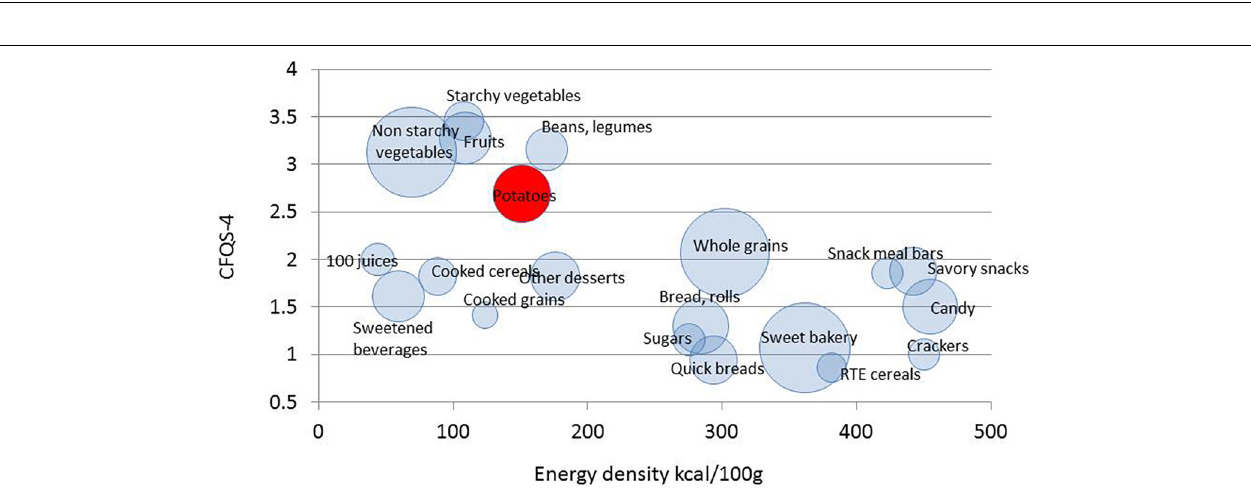
FIGURE 5 | Scatterplot of mean CFQS-4 scores plotted against energy density (kcal/100) by WWEAI food subgroup. The size of bubble represents the number of items in that subgroup.